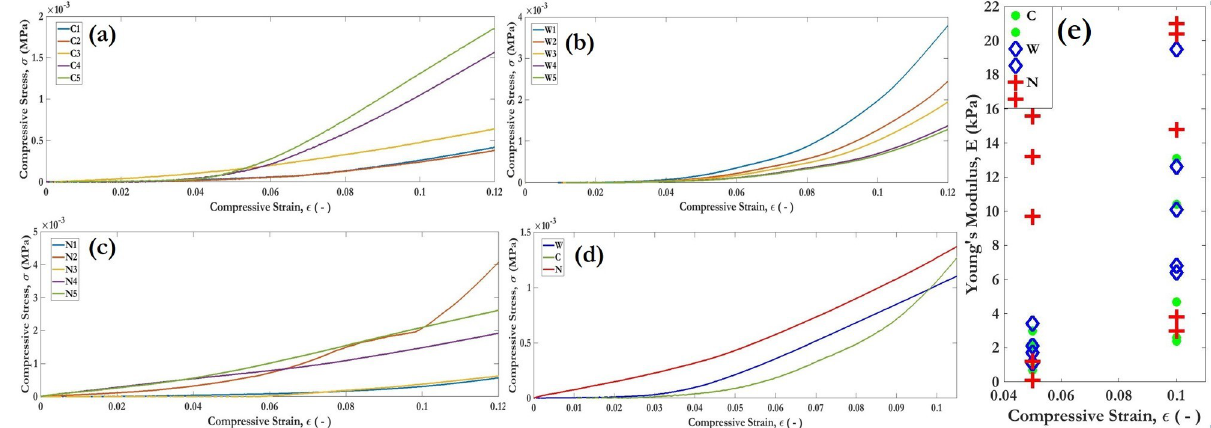
Fig 1. Stress-strain curves and Young’s Moduli for the test specimens: (a), (b) and (c):Engineering stress as a function of engineering strain for low deformation ( ε = 0.1) limit corresponding to C, W and N-sets, (d): superposition of averaged curves from (a)-(c) for direct visual comparison, (e): Scatter Diagram of the Young’s Modulus variation at two strain values (0.05, 0.1). C denotes a control sample which is dry and not treated, N denotes a non-control sample which has been immersed in the bacterial culture and dried before measurements. W is a sample immersed in a non-inoculated culture